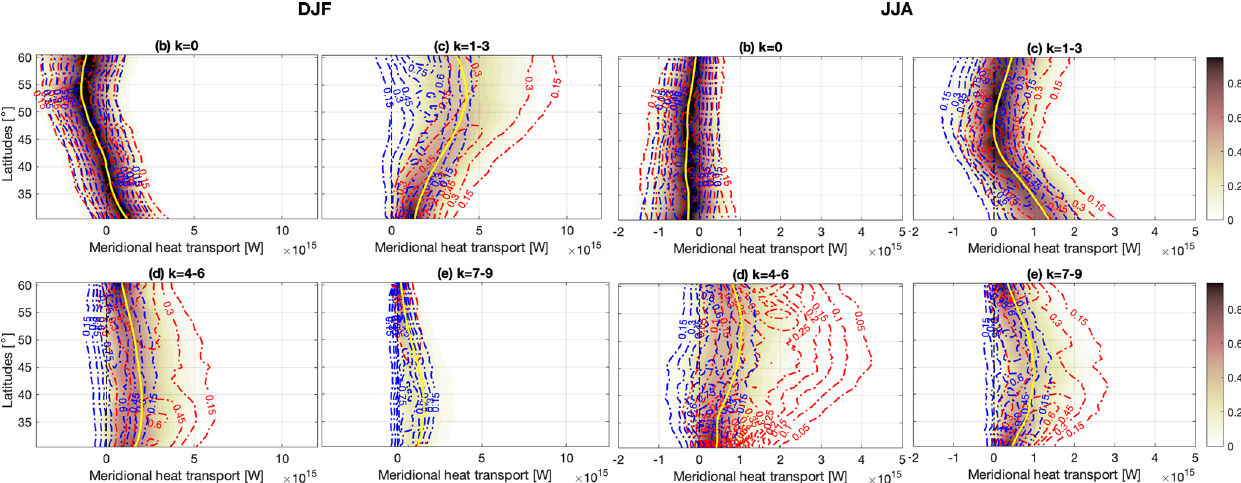
Figure C1. Same as in Fig. 3b–e, for a different wavenumber grouping, in DJF (left) and JJA (right).